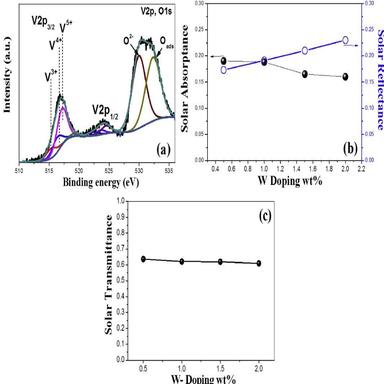
(a) The typical, illustrative, curve fitted V2p and O1s spectra of the as deposited W-FVO thin films on quartz substrates with 2 wt % of W doping, (b) the average solar reflectance and the average solar absorptance and (c) the average solar transmittance as a function of W doping weight percentage of the as deposited W-FVO thin films on the quartz substrates.